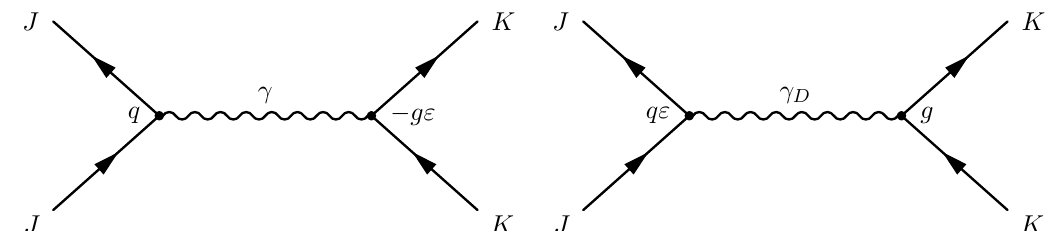
Figure 5 . s -channel production of magnetic monopoles. There are contributions from both the massless photon and massive dark